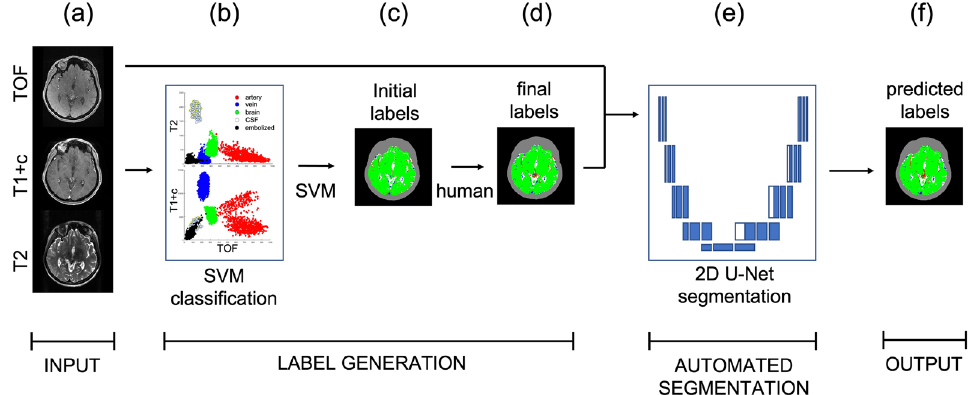
Figure 1. Workflow schematic for algorithm development. ( a ) Magnetic resonance images are co-registered. ( b ) Labels are generated using a support vector machine-based (SVM) algorithm to classify voxels into arteries (red), veins (blue), brain (green), CSF (white), and embolized vessels (black). ( c , d ) Labels are edited manually. ( e ) Final labels and co-registered images are used to train and validate the convolutional neural network. ( f ) Output is a 3D map of the predicted voxel labels. T1 + c: T1 post-contrast; TOF: time-of-flight. CSF: cerebral spinal